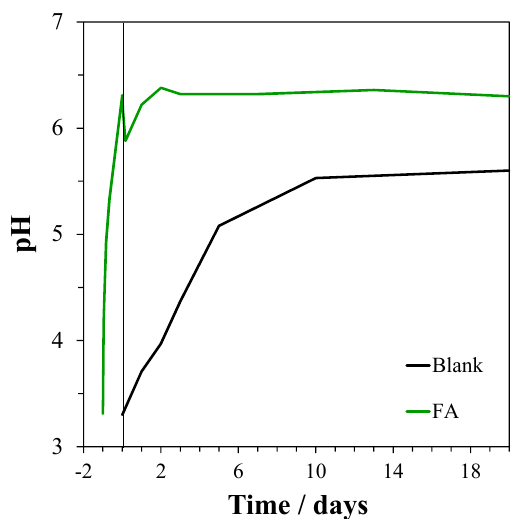
Figure 15. pH values of AR × 10 solution in the presence of suspended FA particles, recorded during the suspension aging and the subsequent immersion of bronze electrodes (starting at time = 0 days). As a reference, the solution pH of AR × 10 (blank) during immersion of bronze electrodes is also reported.